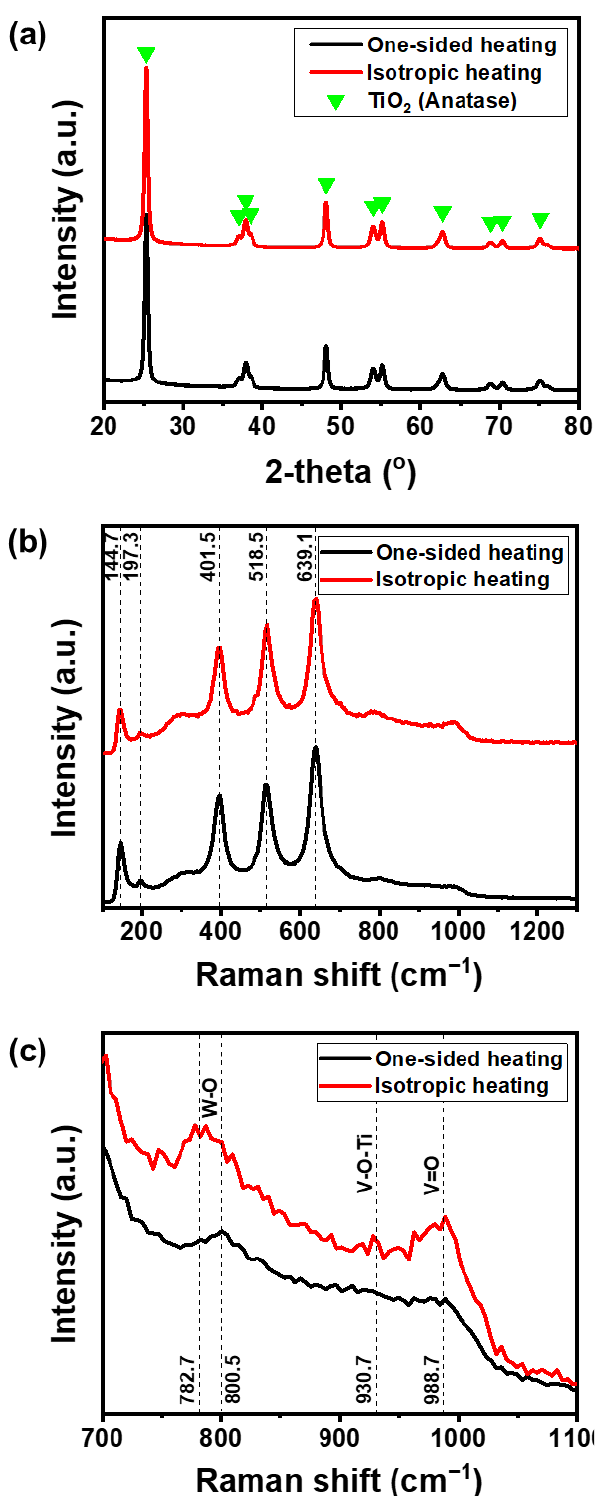
Figure 2. ( a ) XRD patterns and ( b , c ) Raman spectra of V 2 O 5 -WO 3 /TiO 2 with different structures (black and red lines represent the V 2 O 5 -WO 3 /TiO 2 prepared by the one-sided heating and isotropic heating methods, respectively).